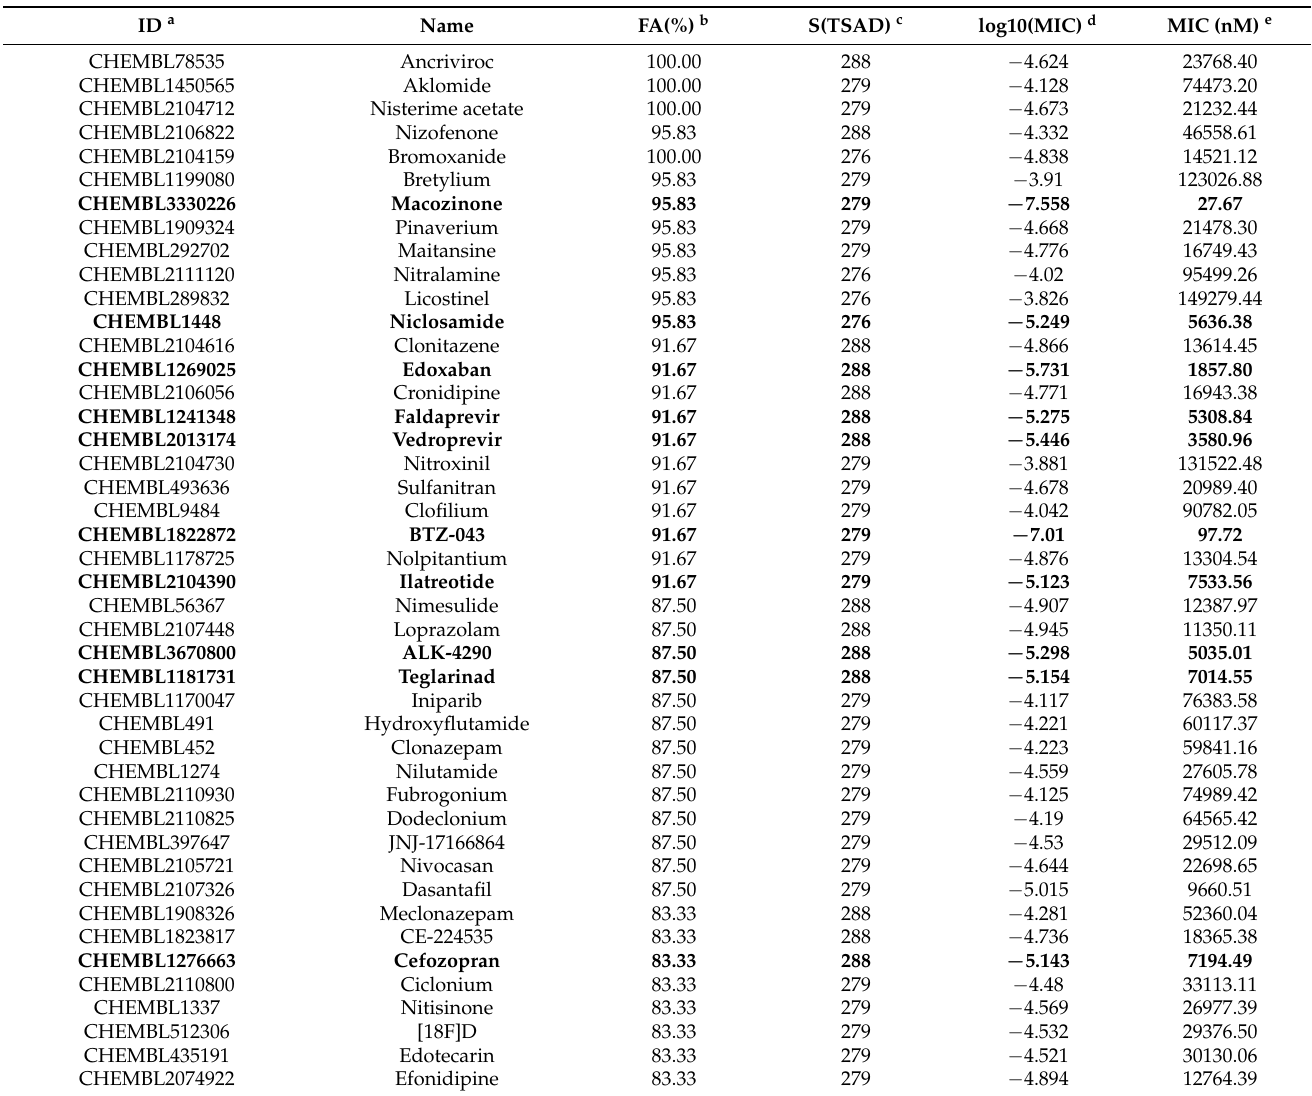
Table 5. Top-ranked regulated chemicals identified by mtc-QSAR-EL as potential multi-strain inhibitors against Mtb (MIC 90 < 7622.22 nM) and predicted by the webserver